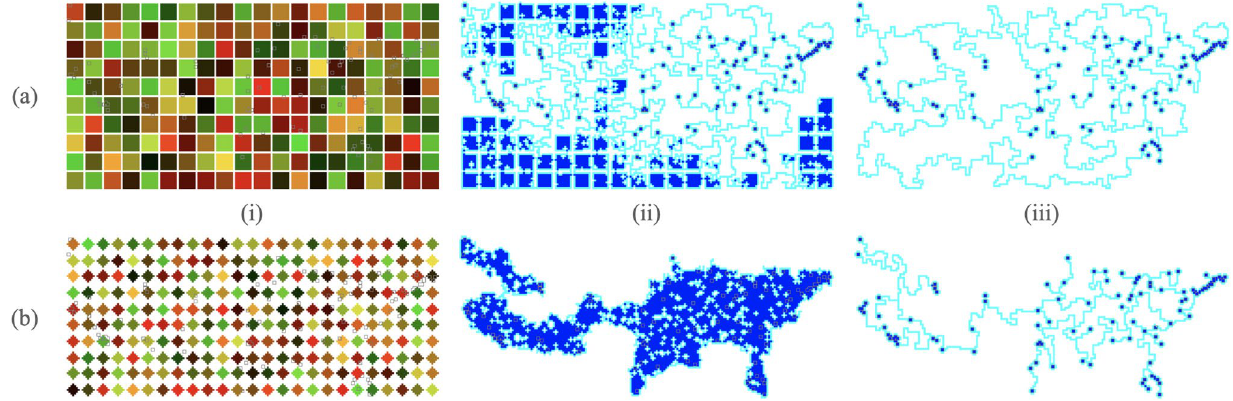
Figure 3. ( a ) Size 9 squares spawned one apart. Bottom image is final solution. ( b ) Size 7 diamonds spawned one apart. Bottom image is final